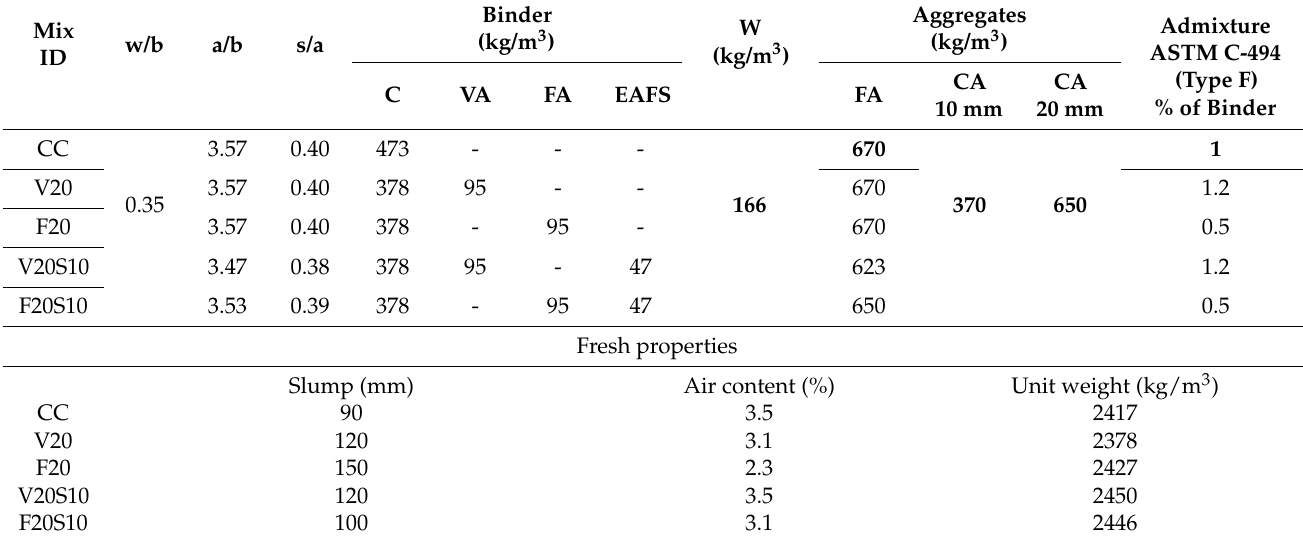
Table 4. Concrete mixture proportions and fresh